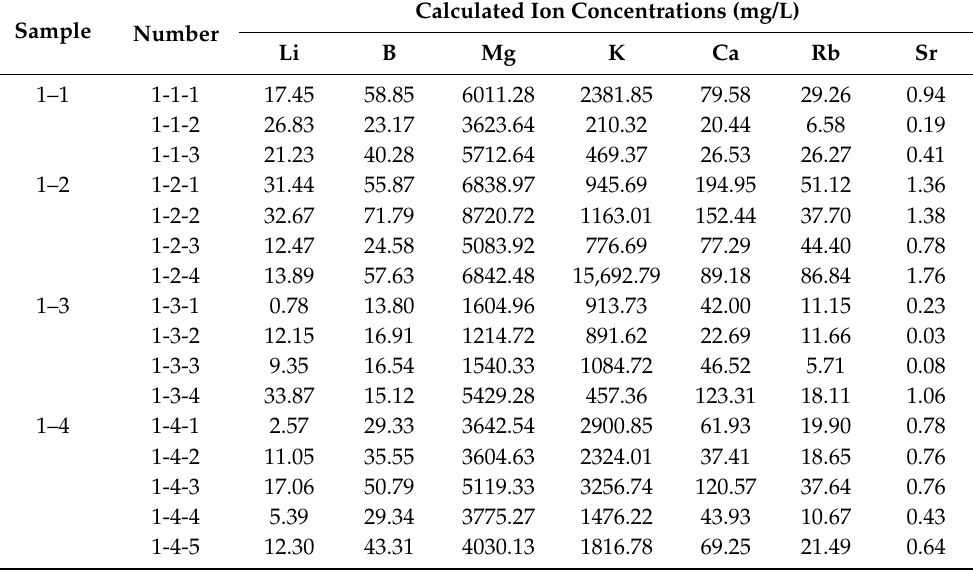
Table 3. Ion contents of halite fluid inclusions from sample 1.